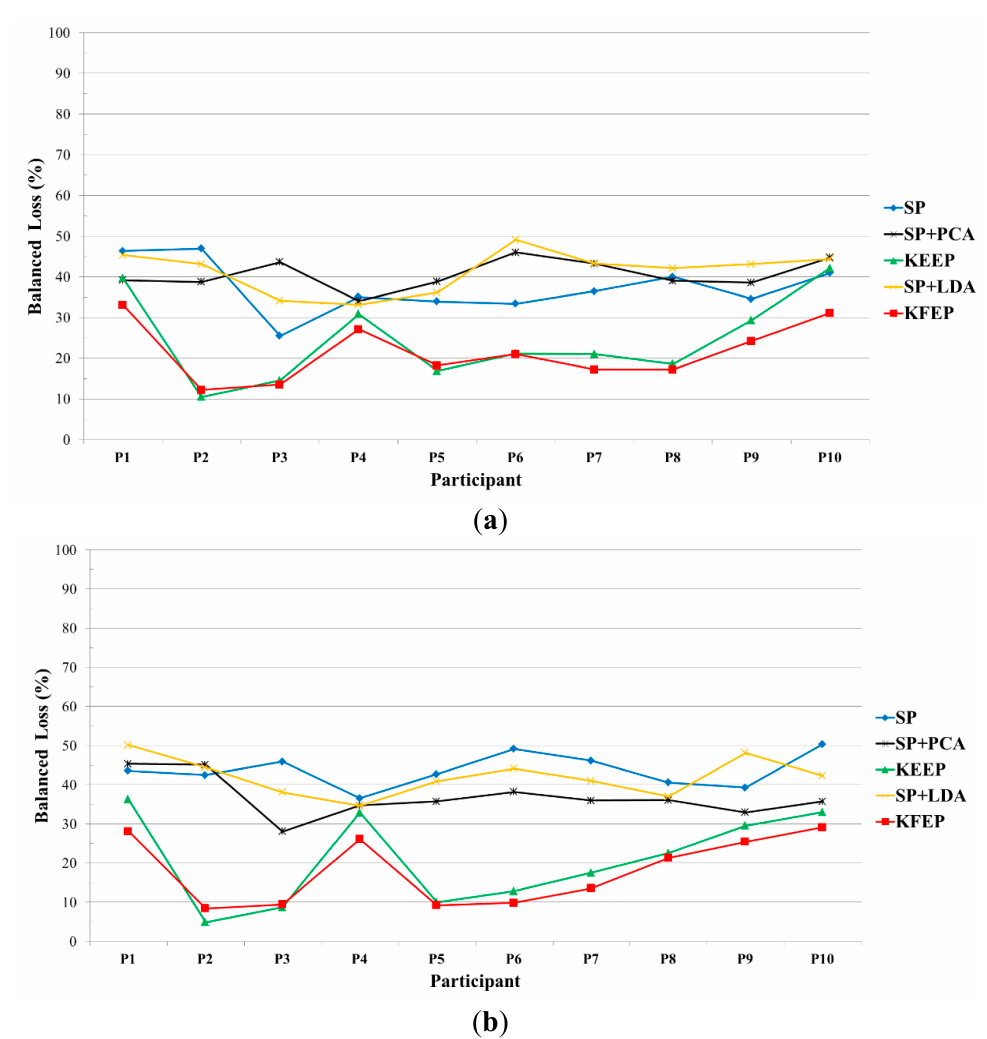
Figure 5. Comparison of the 10-participant error rates among different feature extraction methods in ( a ) valence classification and ( b ) arousal classification, where the classifier is k -NN